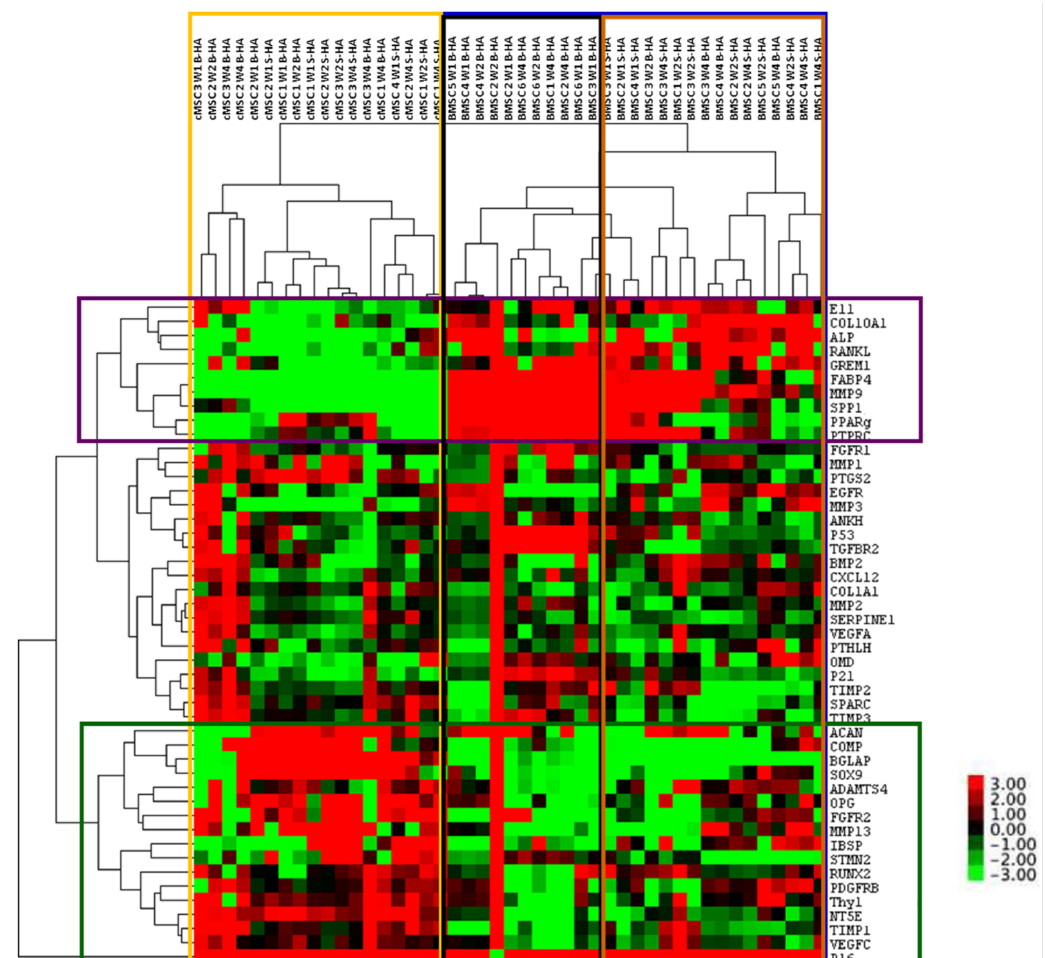
Figure 4. Cluster analysis of all samples and all genes. Cluster analysis of cMSCs and BMSCs after lysis from B-HA and S-HA scaffolds. Labels on the right indicate the genes, and labels on the top indicate samples. The range of gene expression levels varies from the highest expression in red to the lowest in green. Their colour key for the relative expression is on the right. Data are presented for n = 3 cMSCs and n = 6 BMSCs, coloured boxes are explained in the